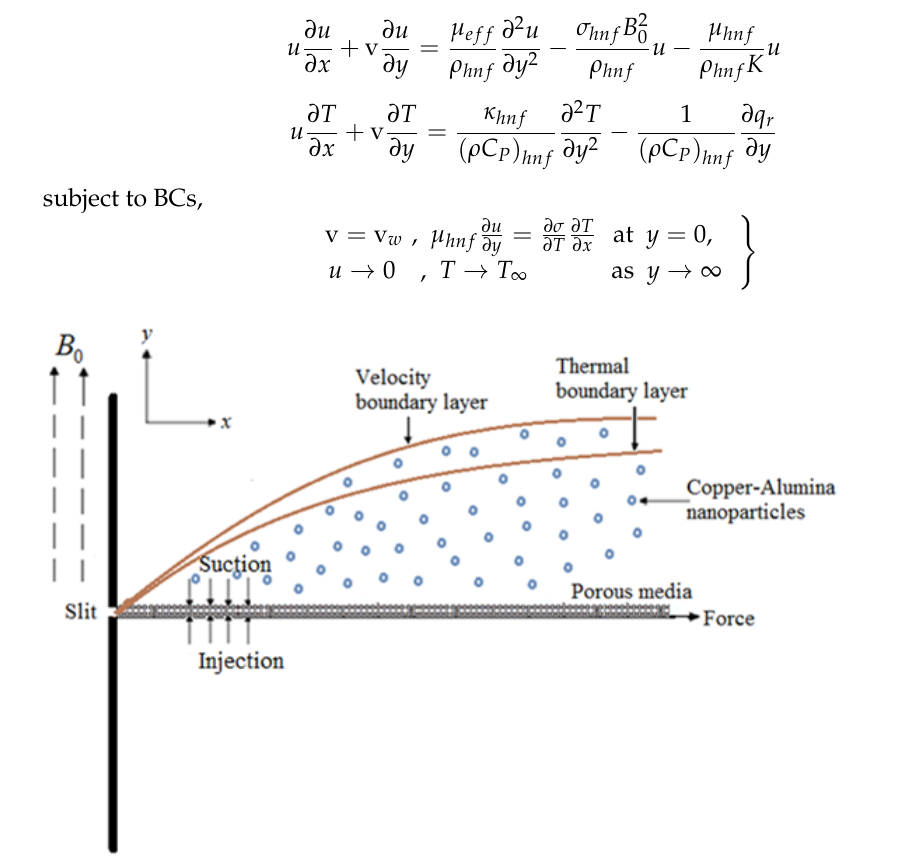
Figure 1. Physical model of the flow.